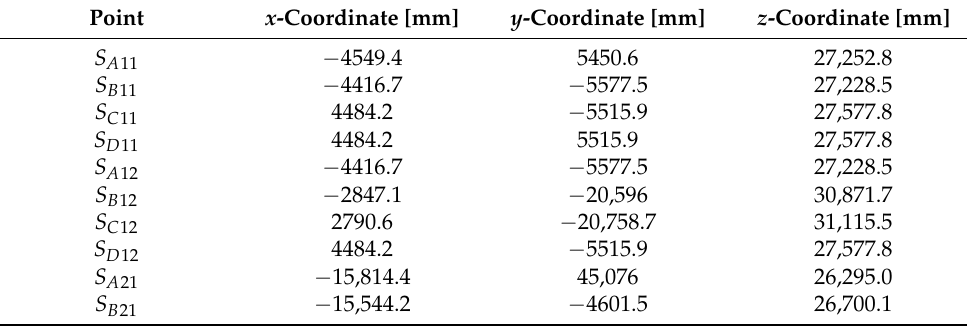
Table A9. The coordinates of the points defining the reference surface ω 3 of the third structure Σ 3